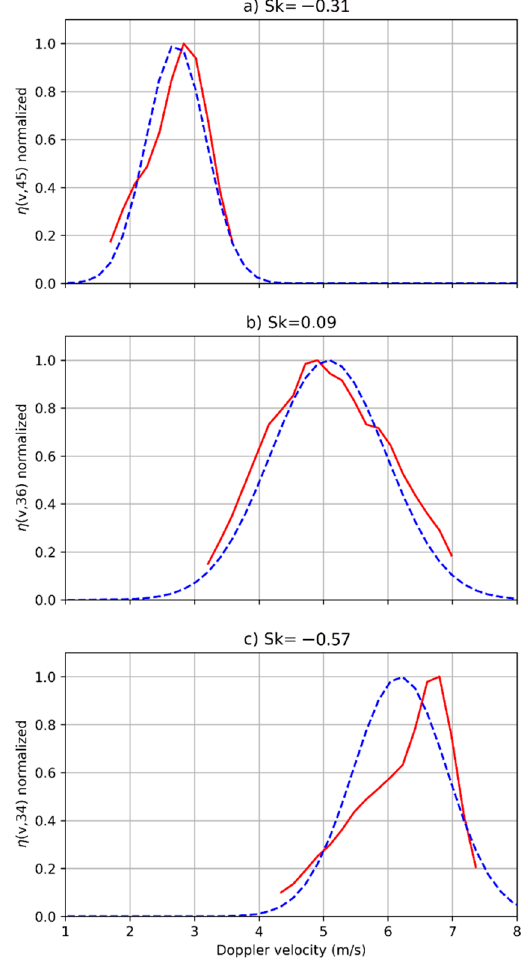
Figure 8. Examples of the Doppler velocity distribution (redsolid line) and fitted normal distribution calculated with the same average Doppler velocity and spectral width (blue dashed line) obtained at three different heights: ( a ). above the Bright Band (2350 m ASL), ( b ). within the Bright Band (1900 m ASL) and ( c ). below the Bright Band (1800 m ASL), on 5 December 2019. Skewness values (Sk) are given for each height.